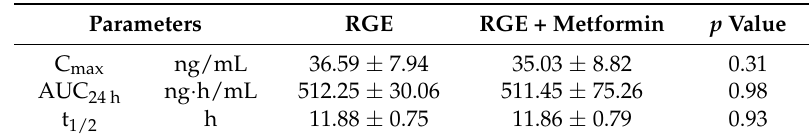
Data points are means ± SD of five rats. p value indicates static comparison between two groups using student t -test.